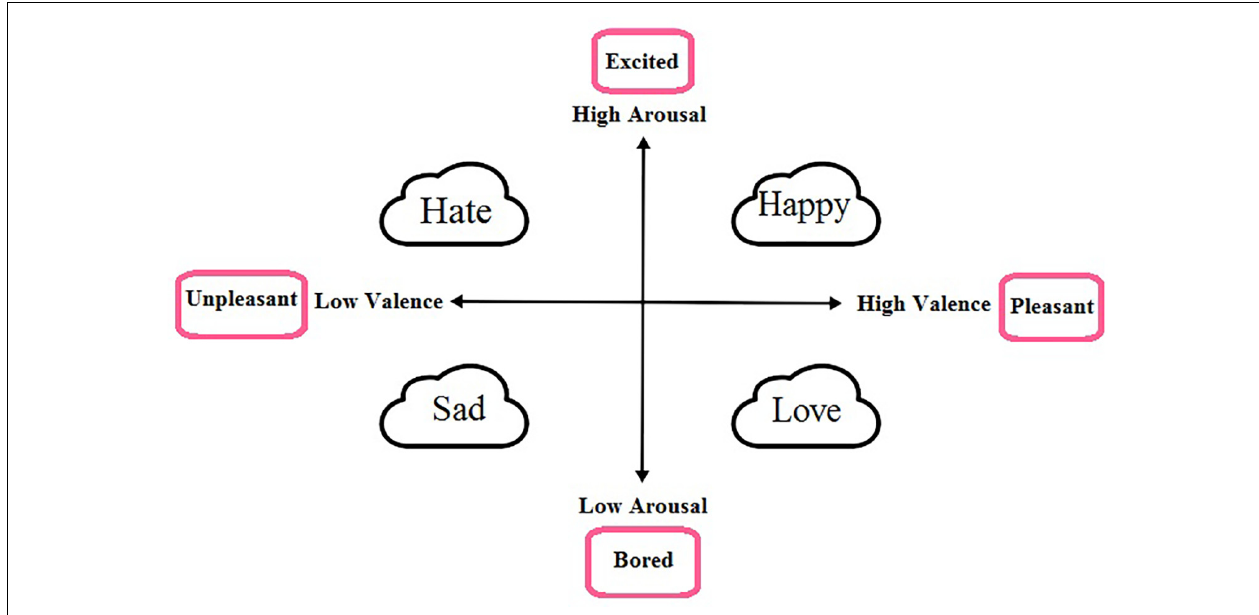
FIGURE 1 | Representation of dimensional model for emotions , this model defines all emotions on a two dimensional space, valence and arousal. Valence denotes the polarity of emotions [positive (pleasant) or negative (unpleasant)] and arousal shows the amount of excitement [high (excited) or low (bored)]. As seen in the figure, discrete emotions, based on the amount of arousal and valence values, can be shown on this dimensional